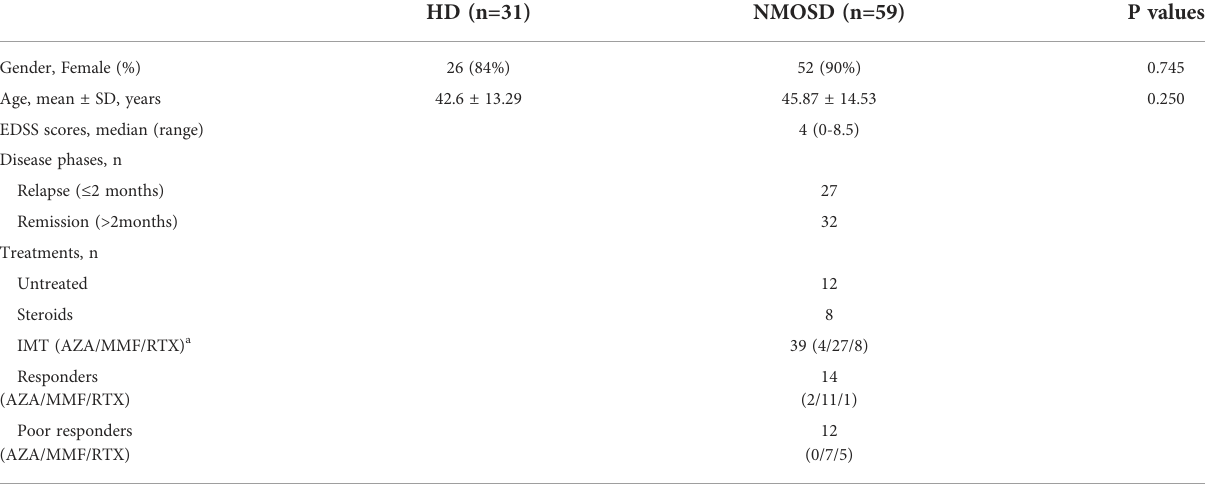
TABLE 1 Demographic and clinical characteristics of